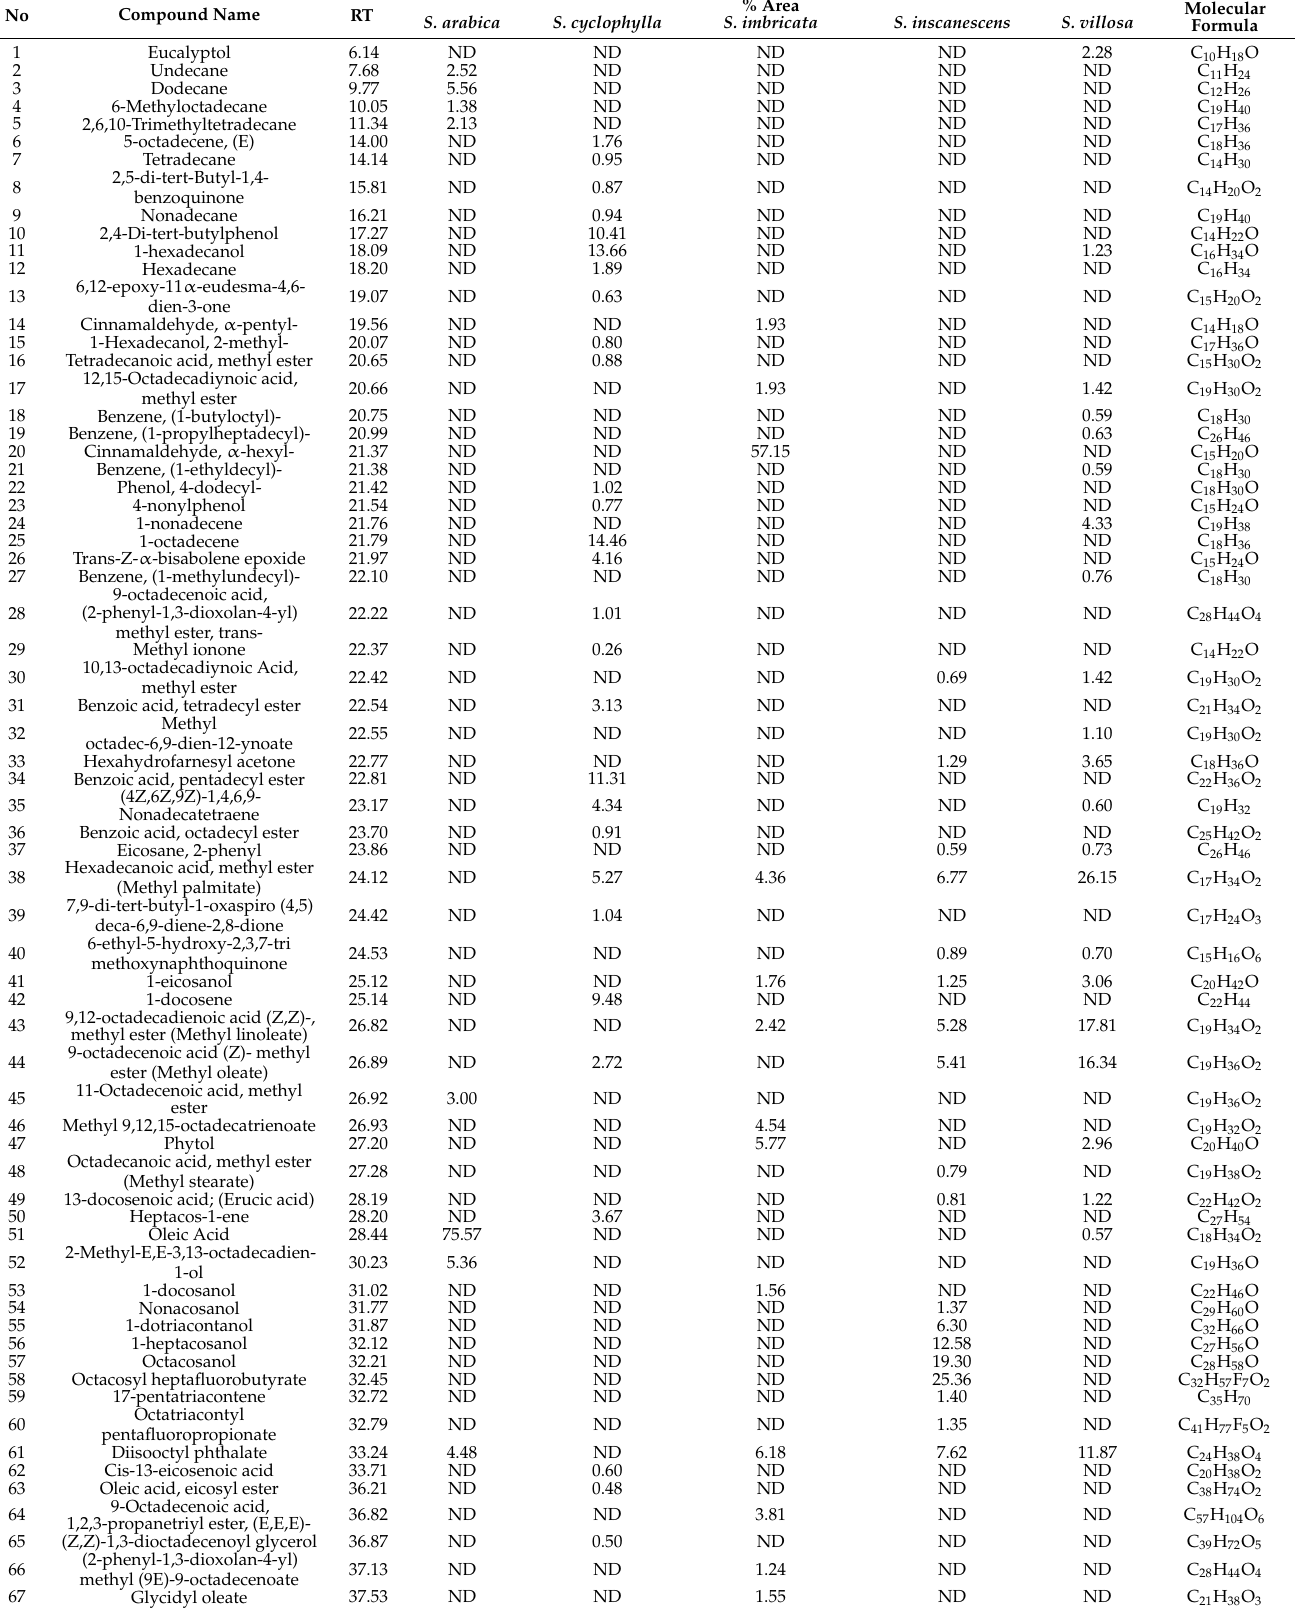
Table 1. GC-MS data of the n-hexane extracts of different Salsola